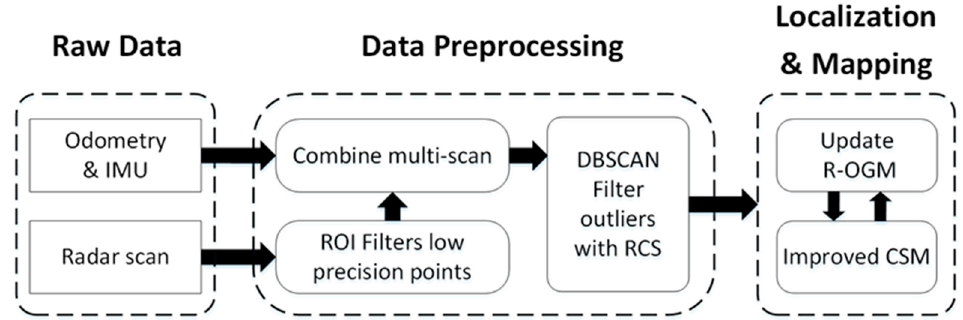
Figure 1. Composition of millimeter-wave radar Simultaneous Localization and Mapping (SLAM) assisted by the Radar Cross Section (RCS) features of the target and Inertial measurement unit (IMU).